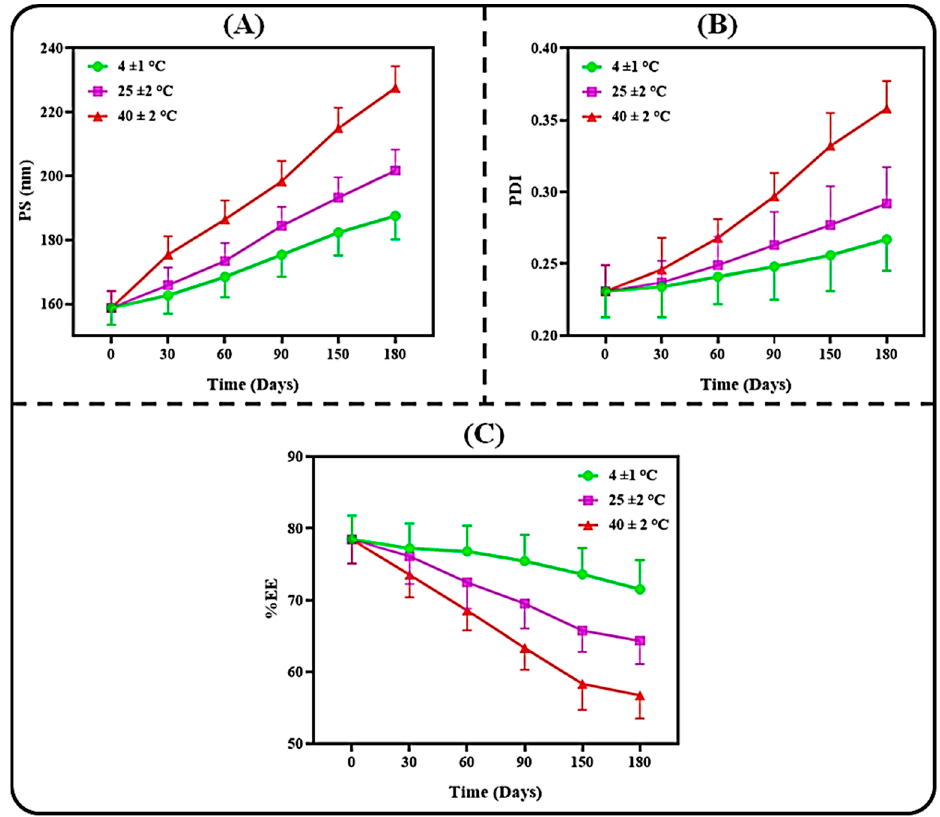
Figure 6. Colloidal stability of PPN-LPHNPs at different environmental conditions and different time intervals on ( A ) PS, ( B ) PDI, and ( C ) %EE.